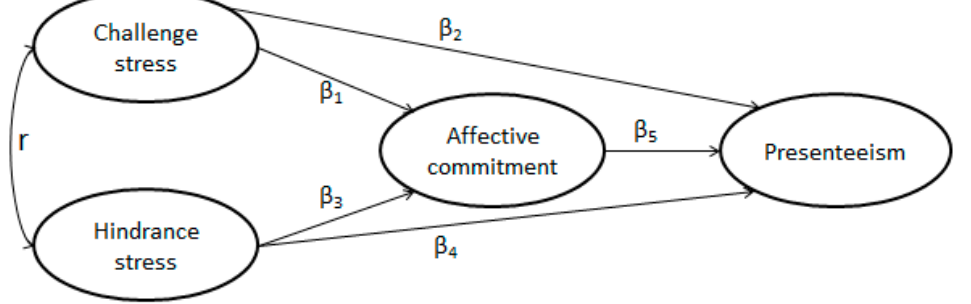
Figure 1. Proposed model of how challenge stress, hindrance stress, and affective commitment affect presenteeism.